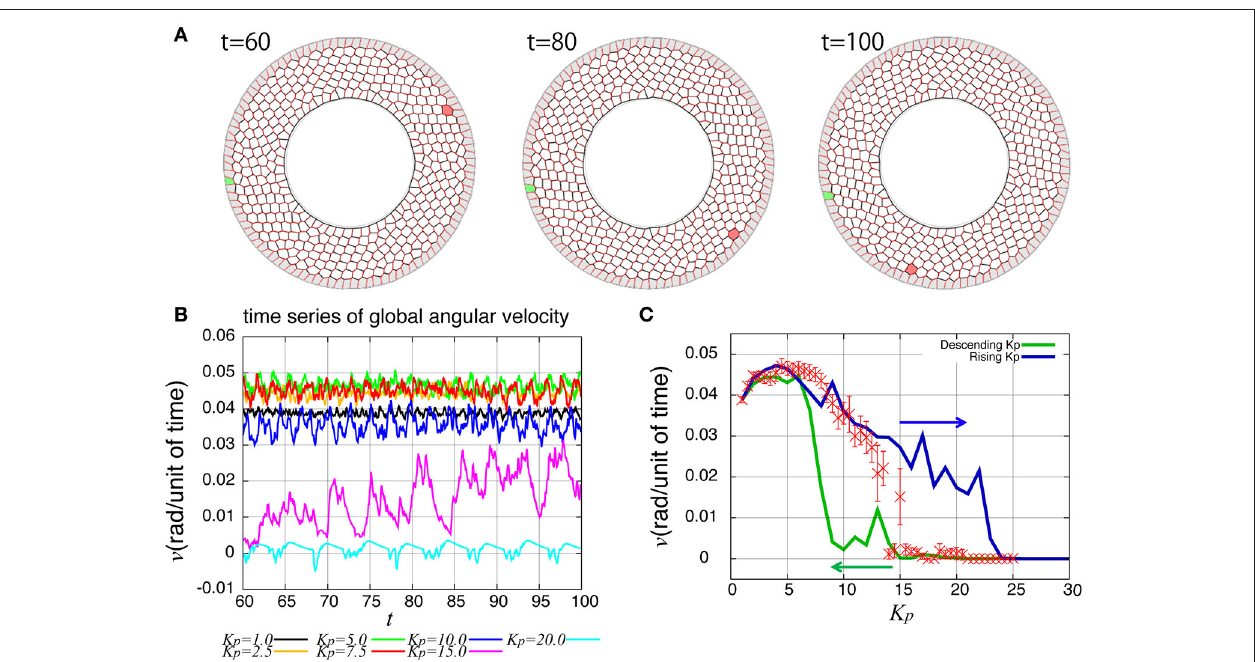
FIGURE 2 | Rotational motion of the genital disc in the absence of line tension fluctuation. (A) Time-lapse images of genital disc rotation. (B) Time evolution of global angular velocity for various values of K p . (C) K p -dependence of the global angular velocity. The angular velocity was averaged over the time window from t 100 (red). Error bars indicate the standard deviation in the time course. Hysteresis curves for the global angular velocity were plotted for increasing and decreasing parameter values (blue and green lines,